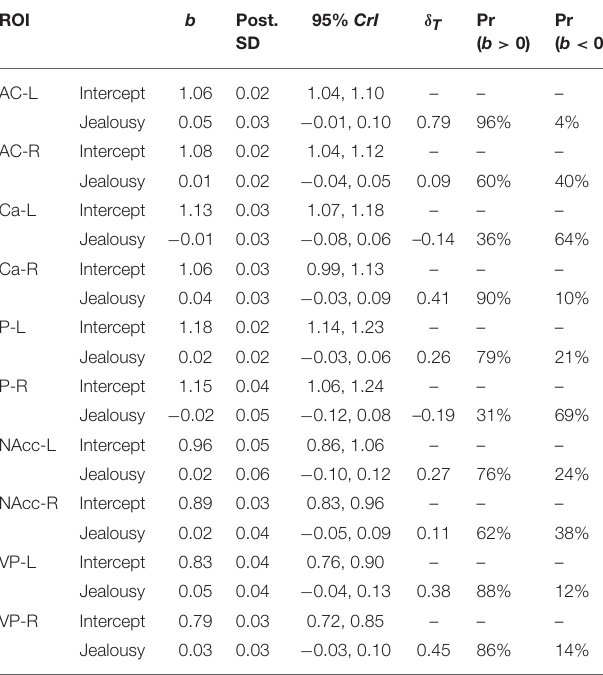
Intercept is the model estimate for the control condition. Jealousy is the difference from the control condition—the jealousy effect. Post. SD is the posterior standard deviation of the estimate. These estimates were all obtained from the same model. Interpretation of ( δ T ) follows Cohen’s d (small = 0.2, medium = 0.5, large = 0.8).